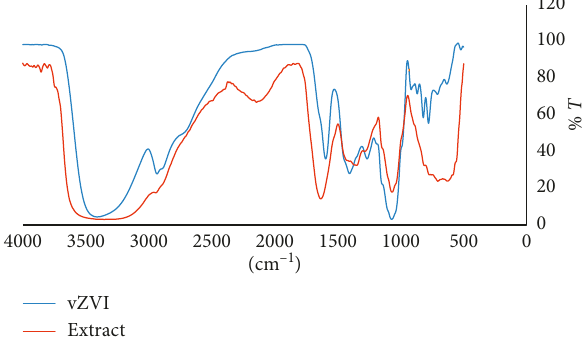
Figure 4: FTIR spectra of vZVI nanoparticles and V. floribundum Table 2: FTIR peaks for extract and nanoparticles. Extract Nanoparticles Peak